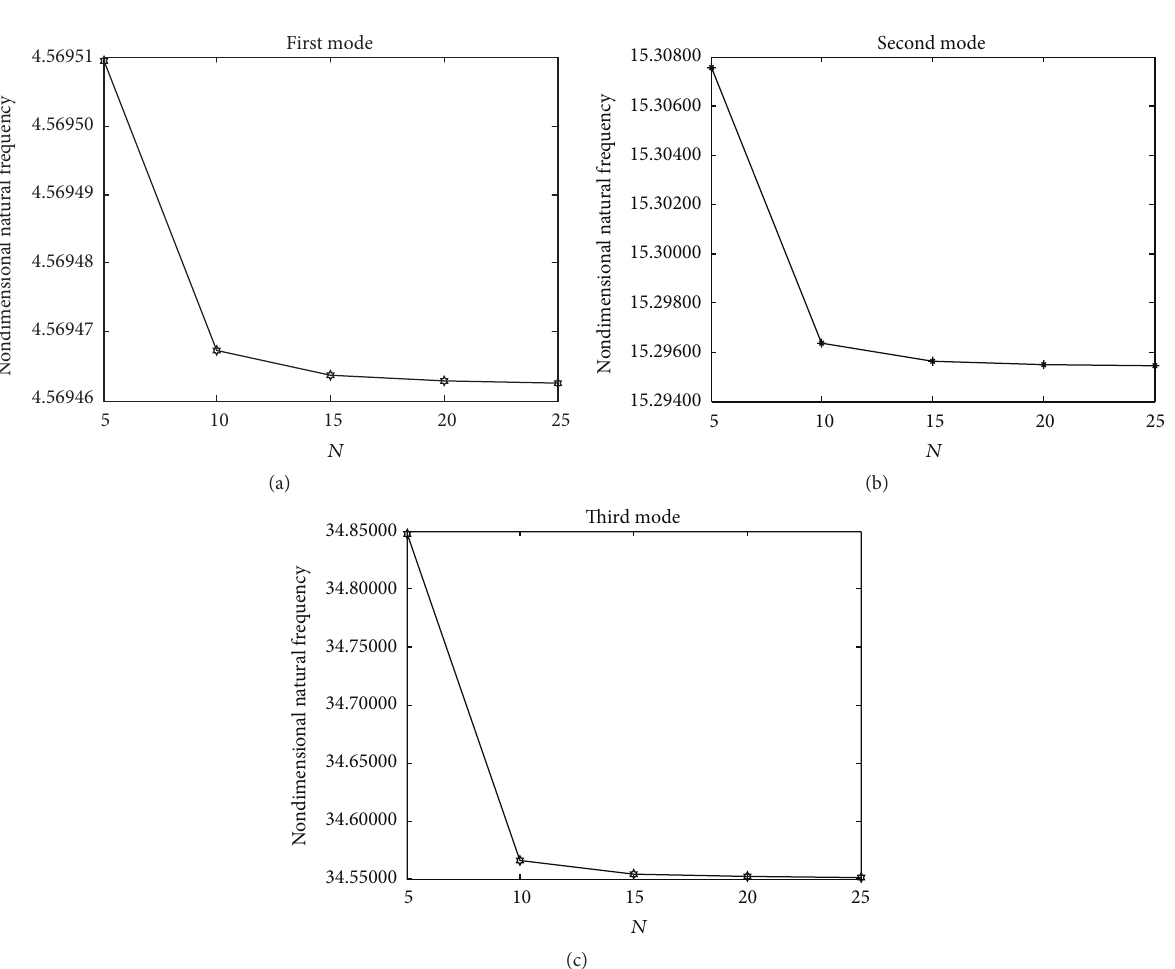
Figure 6: Convergence of natural frequencies for axially FG tapered cantilever beams with respect to spline node number N (𝑐 𝑏 = 𝑐 ℎ = 0.8) .